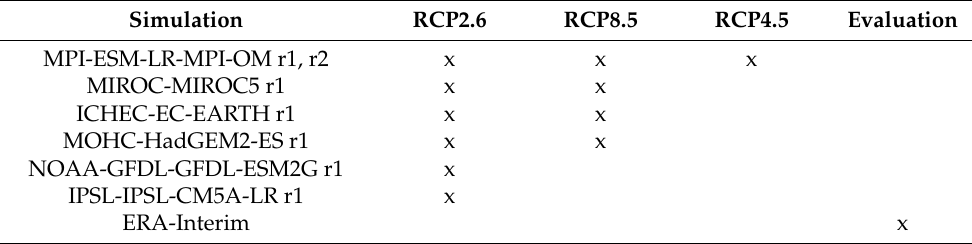
Table 1. REMO simulations of the multi-model and multi-member ensemble forced by differ- ent future RCP scenarios and GCMs respectively a reanalysis simulation (r1 = first realization, r2 = second